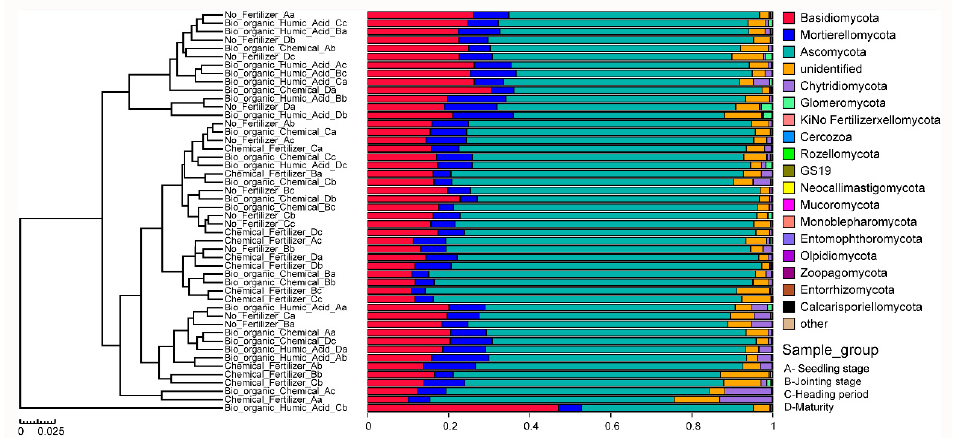
Figure 4. The impact of different fertilization methods on the relative abundances of the top four fungi genera during stage of ( a ) seedling, ( b ) jointing stage, ( c ) heading period, and ( d ) maturity. Values are mean and standard deviation (±SD, n = 3), different letters correspond to significantly different values as determined via one-way ANOVA ( p < 0.05).